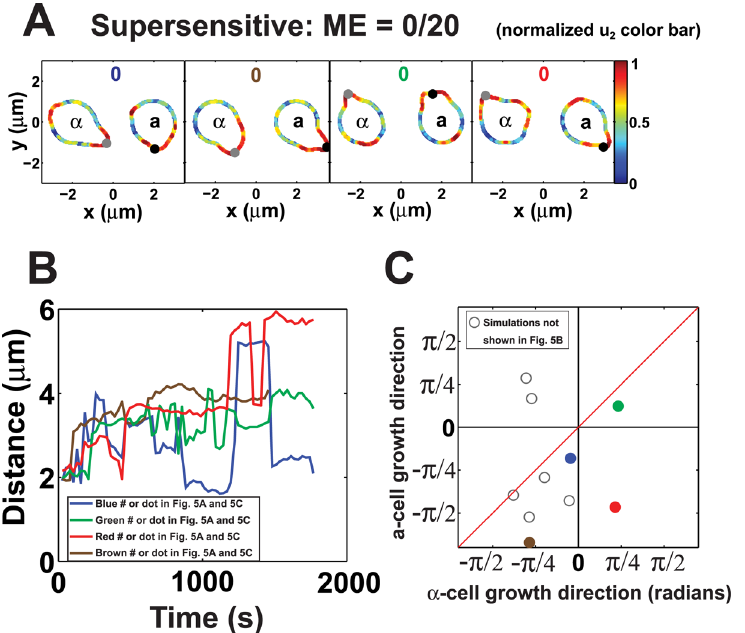
Fig 5. Reduced mating efficiency for supersensitive cells. (A) Polarization plots of u 2 showing four pairs of supersensitive mating cells at the end time point. The spatial distribution of u 2 is represented according to the normalized color map on the right. The 0 ’ s indicate that none of the matings were successful. Both cells had β 2 = 2.5. (B) Distance plot showing trajectories from four sample supersensitive mating simulations. The distance between polarisomes was plotted as a function of time. The distances did not steadily decrease as was observed in the normal sensitivity simulations. The four plots are color-coded to match with the polarization plots. (C) Direction plot for supersensitive cell mating simulations. Many of the data points lie far off the diagonal indicating that the cells are not pointing toward each other; the average distance from the diagonal is 0.68 radians compared to 0.12 for the normal sensitivity